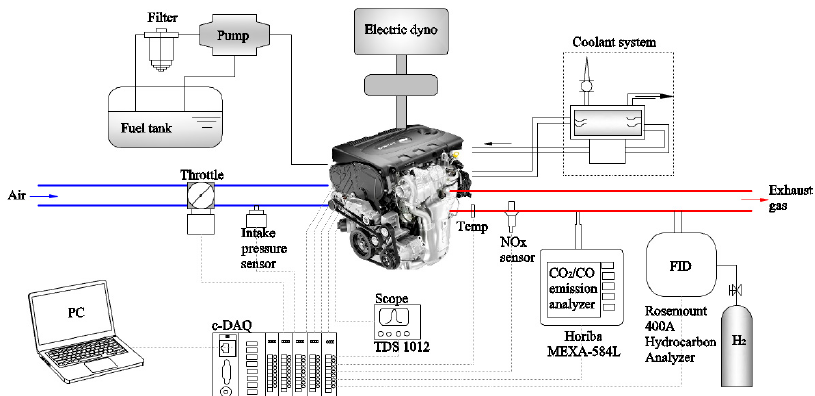
Figure 1. Sketch of the engine bench system.